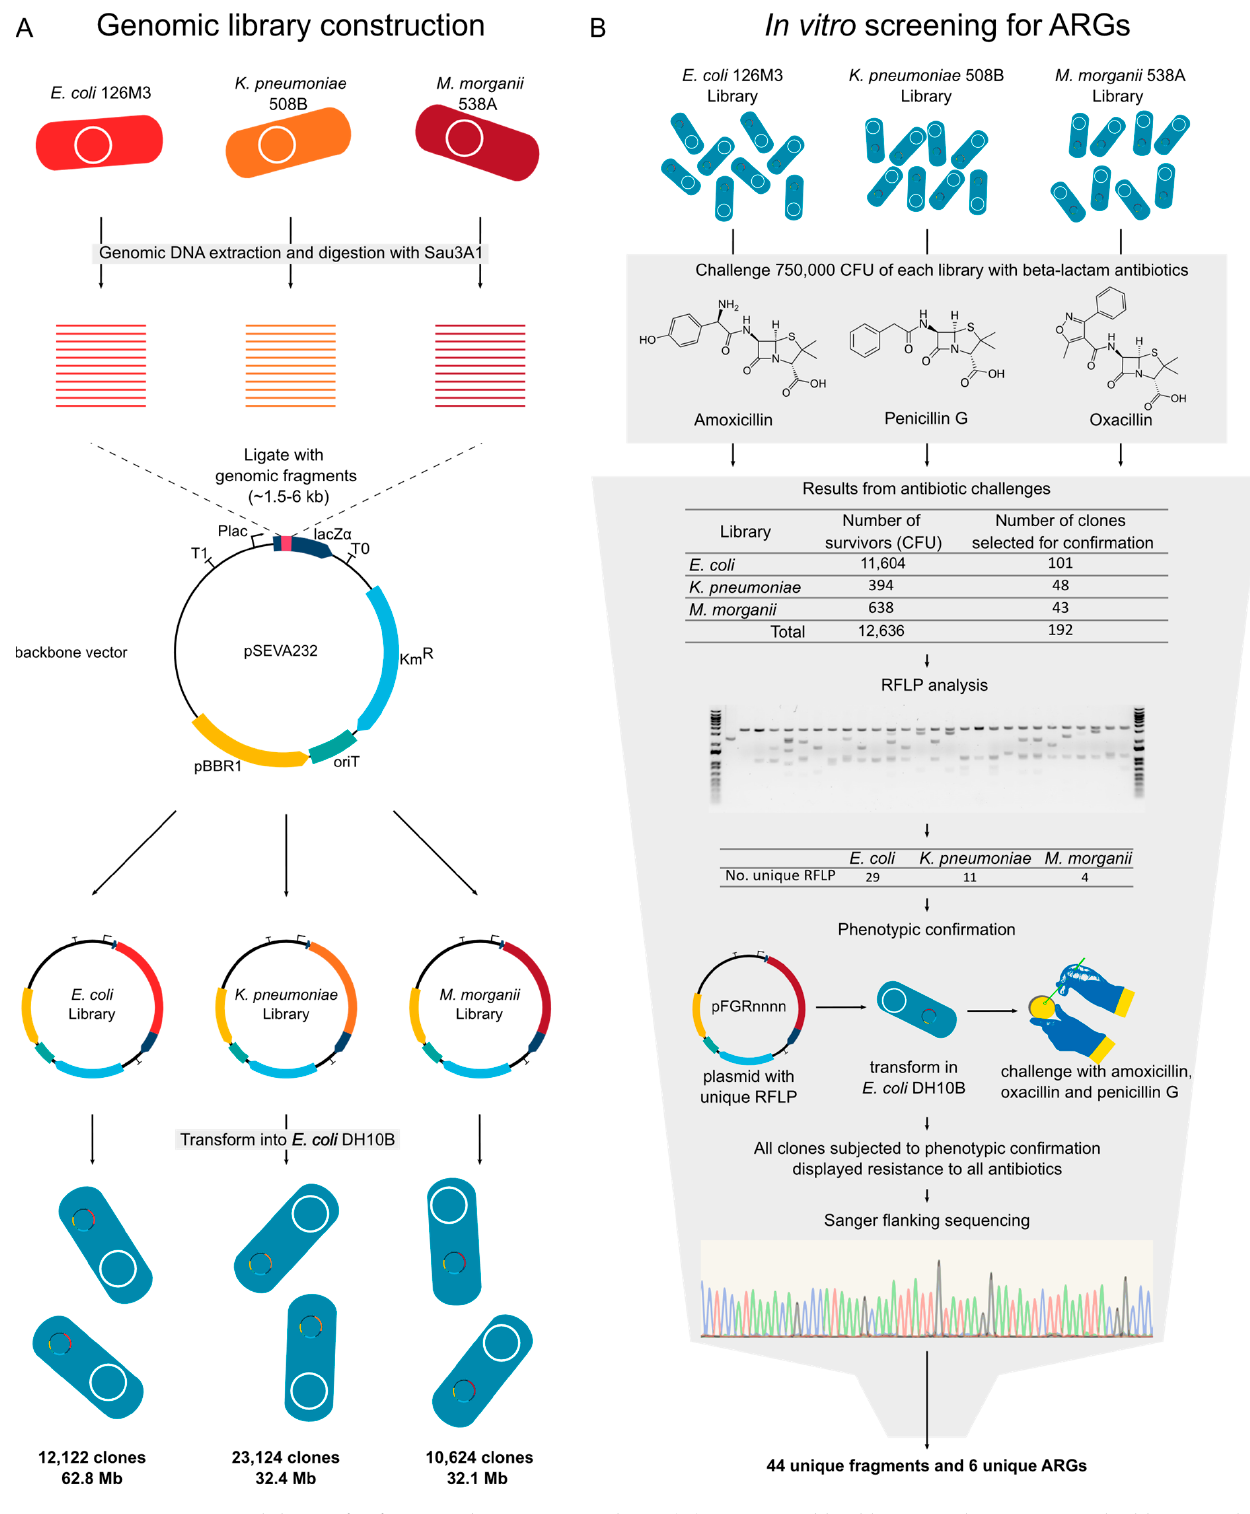
Figure 5. Experimental design for functional genomics analysis. ( A ) Strains and backbone used to construct the library and features of the obtained libraries. ( B ) Functional screening for beta-lactam resistant clones, phenotypic confirmation, and sequence identification. CFU: Colony forming unit; RFLP: Restriction fragment length polymorphism; KmR: Kanamycin resistance marker; pBBR1: A broad host range oriV ; lacZ α : lacZ α gene with multiple cloning site; Plac : Plac promoter; pFGRnnnn: plasmid naming schema.